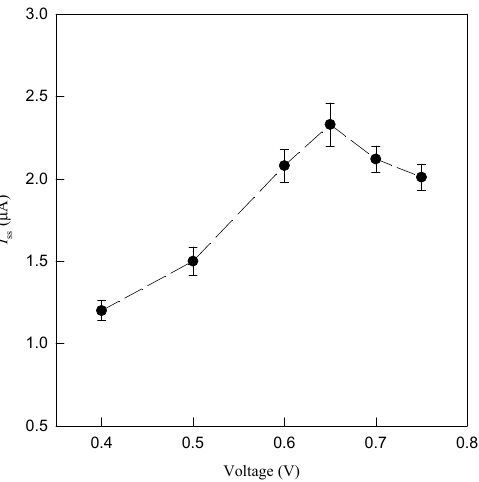
Figure 8 . Effect of applied potential on the detection of 50 μ M tryptophan in 0.5 M KCl